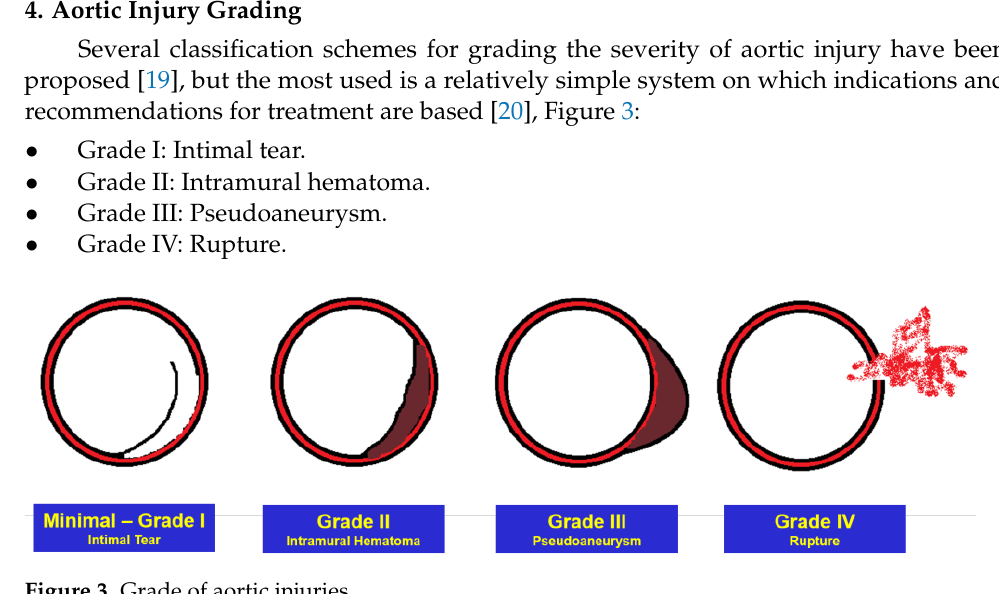
Figure 2. Transesophageal echocardiography showing the presence of an intimal flap (red arrow). The presence of a mediastinal hematoma can also be accurately diagnosed using TEE [15], as well as the presence of wall thrombi within the aortic lumen, which are typically located in the proximal descending thoracic aorta.